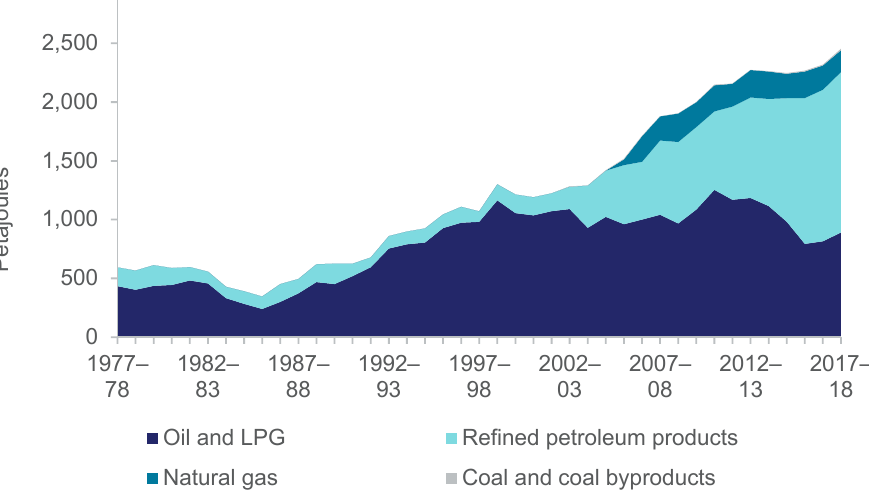
Figure 3. Australian energy imports by fuel type (Australian Government Statistics, 2019).